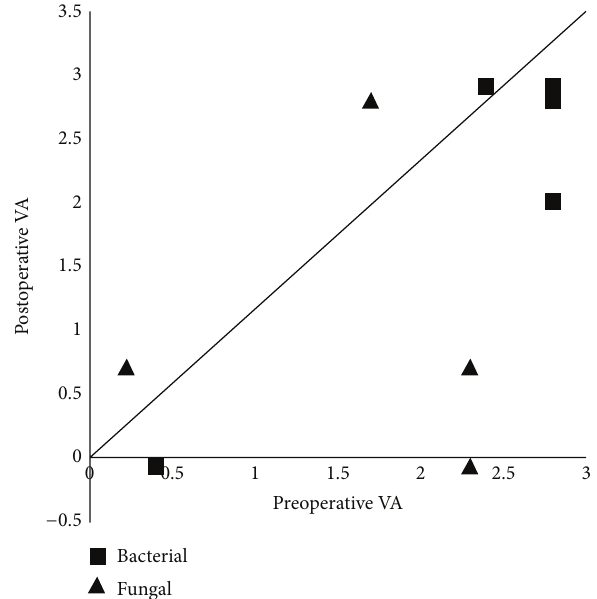
Figure 1: Comparison of pre- and postoperative visual acuity in 10 eyes treated for endogenous endophthalmitis. VA: visual acuity.